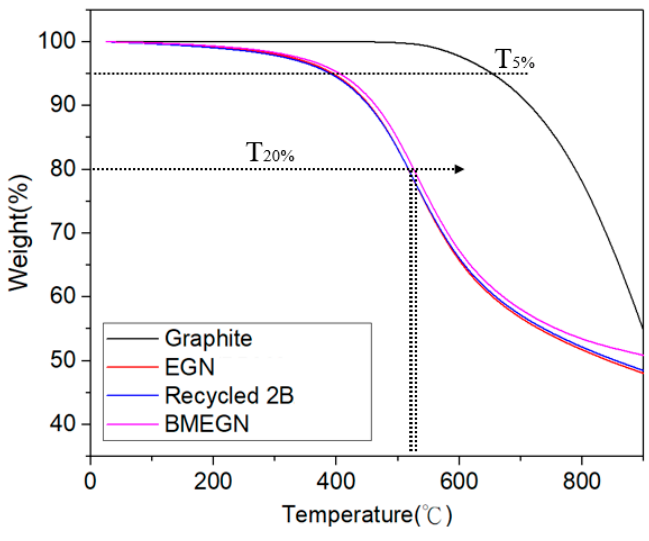
Figure 6. TGA curves of pure EGN, recycled 2B, BMEGN and graphite composites.